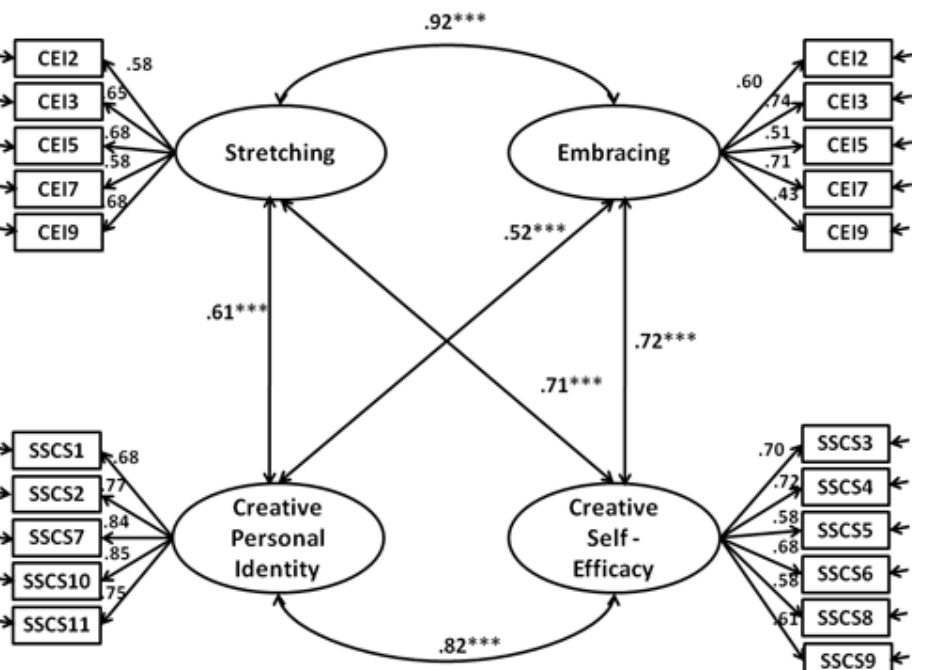
Figure 1. The relationship between stretching, embracing, creative self-efficacy and creative personal identity